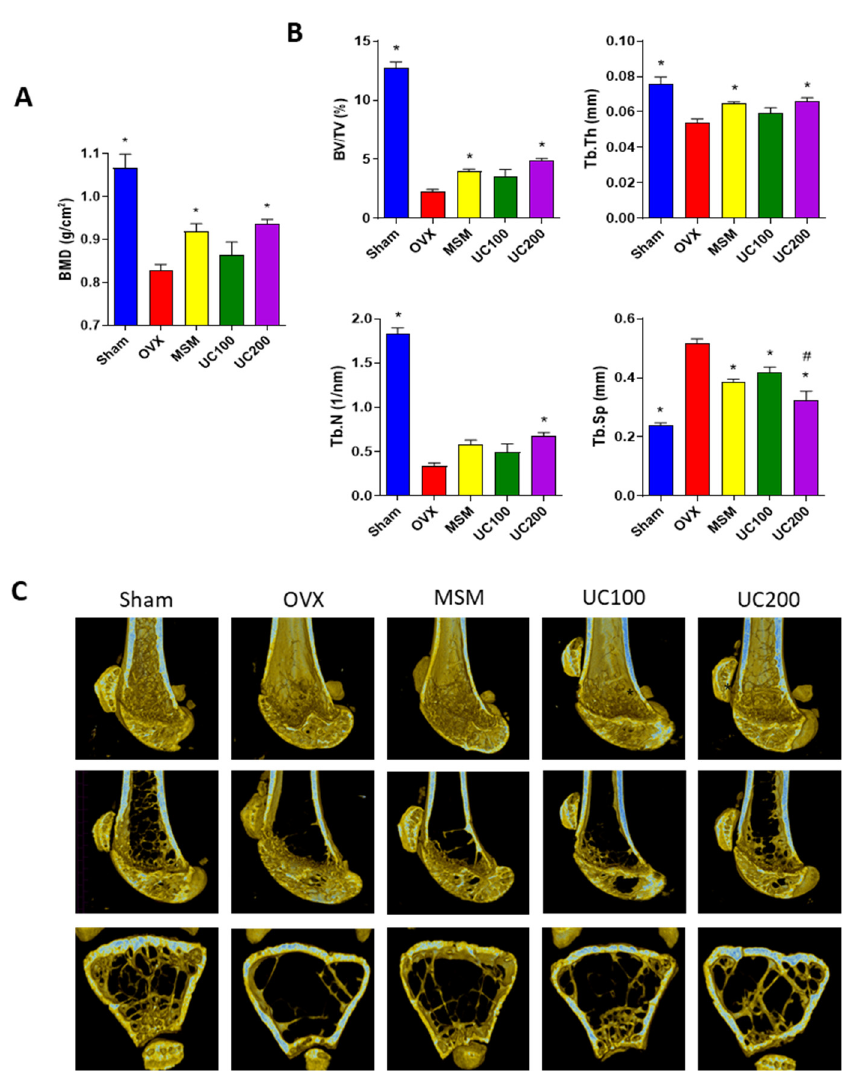
Figure 7. Osteoprotective effects of UC extract on OVX mice. OVX mice ( n = 5 for each group) were provided with 5:5 ratio of UC extract (100 or 200 mg/kg/day) or methylsulfonylmathane (MSM, 300 mg/kg/day) for 12 weeks. ( A ) Bone mineral density (BMD), ( B ) trabecular parameters such as bone volume (BV/TV), trabecular thickness (Tb.Th), trabecular number (Tb.N) and trabecular space (Tb.Sp) were determined; ( C ) representative images of transverse micro-CT were presented after 12 weeks of administration. UC, Ulmus davidiana (UD) and Cornus officinalis (CO) 5:5 ratio treatment; * p < 0.05 vs. OVX; # p < 0.05 vs. UC100 (one-way ANOVA with Tukey’s multiple comparison